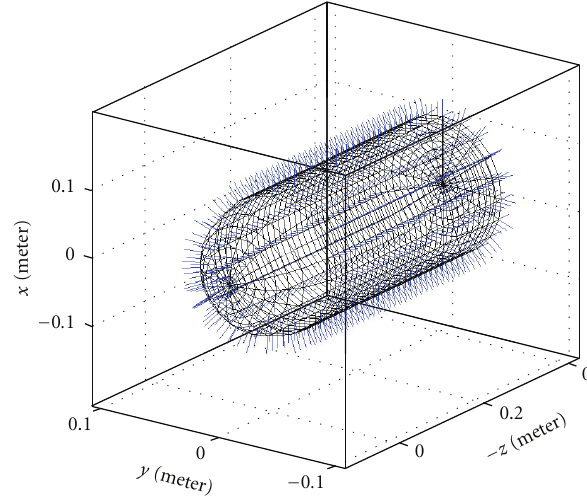
Figure 3: Normal vectors (blue lines) on the object